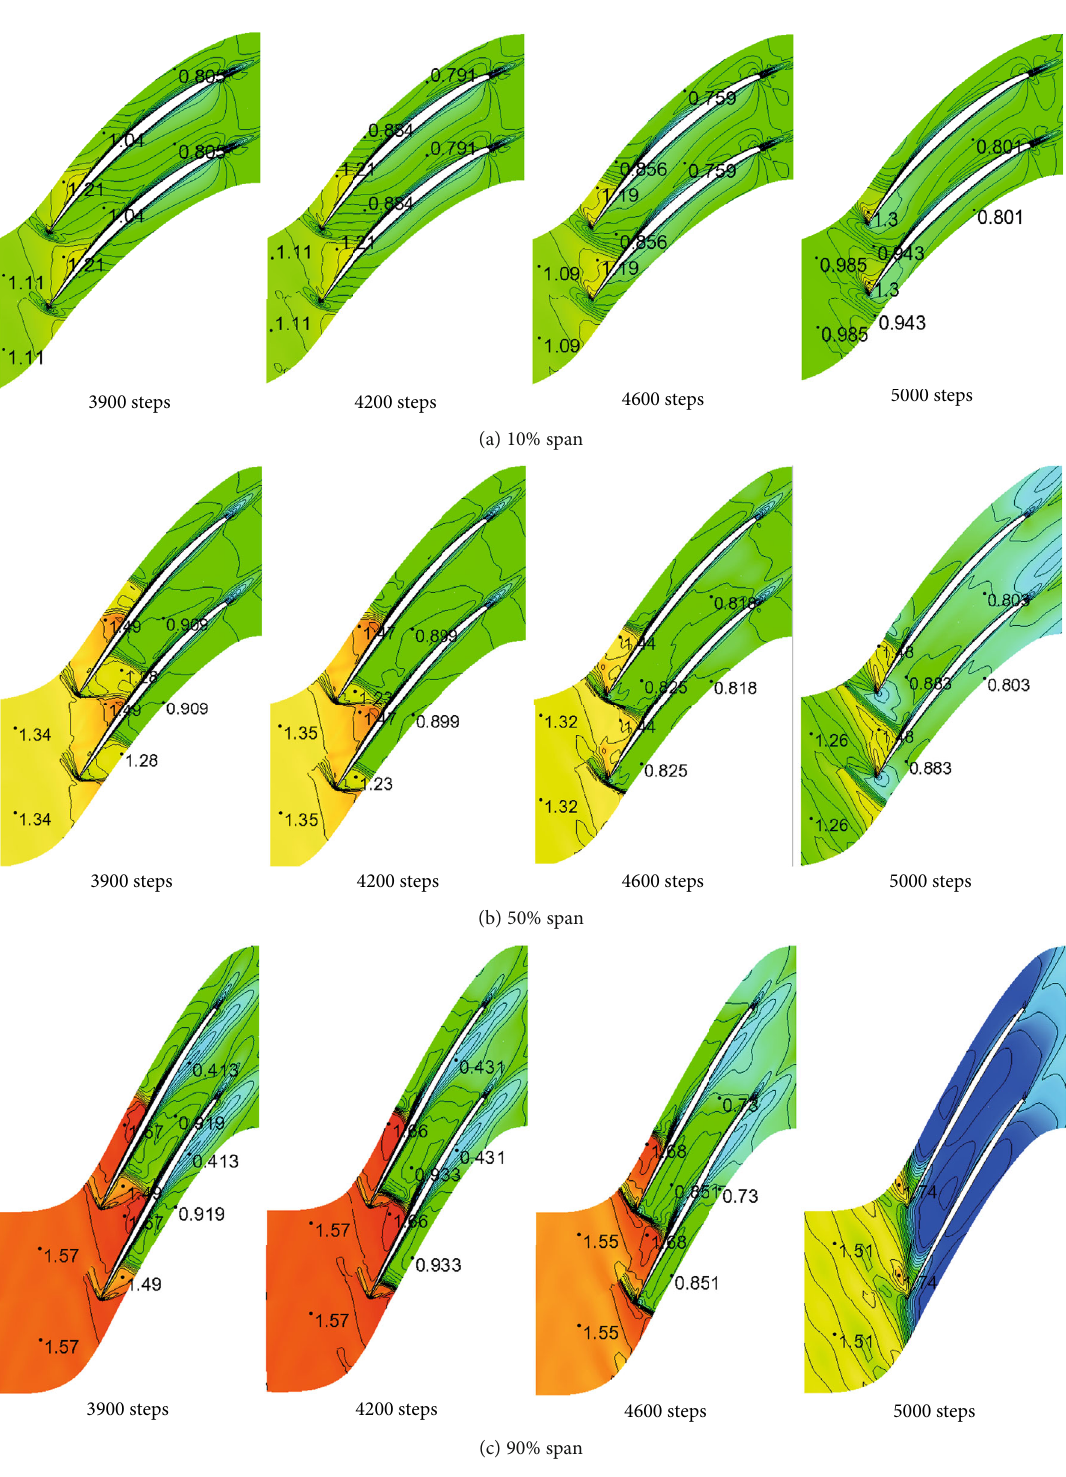
Figure 12: Stall development of the 3D-opt